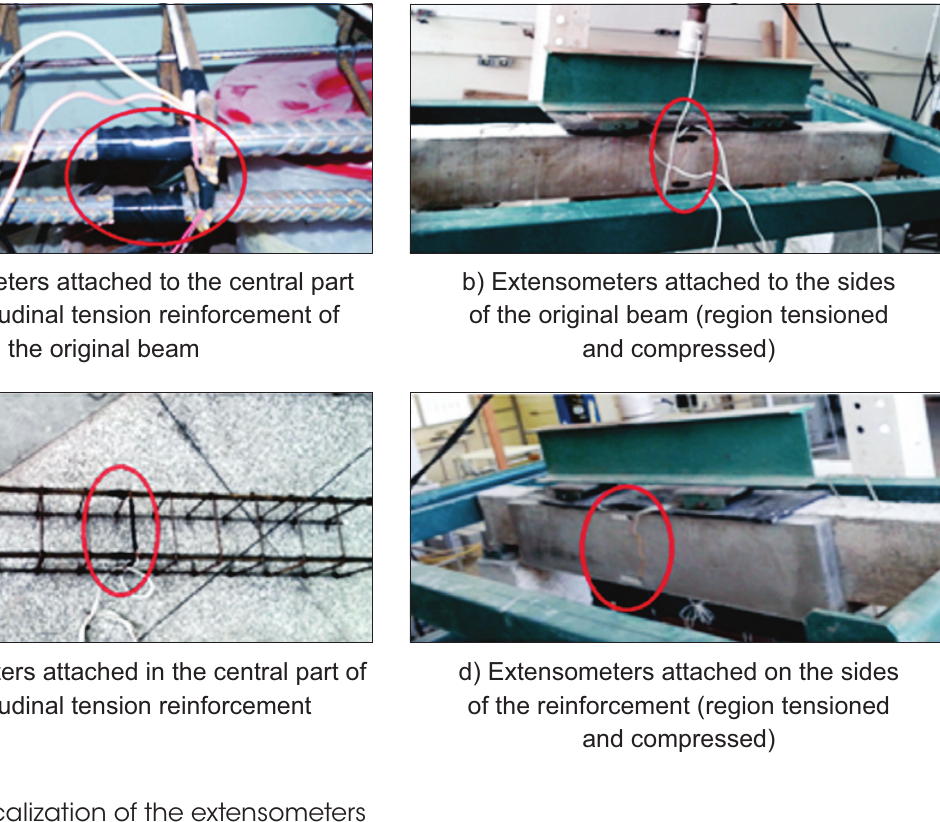
Schematic of the localization of the extensometers